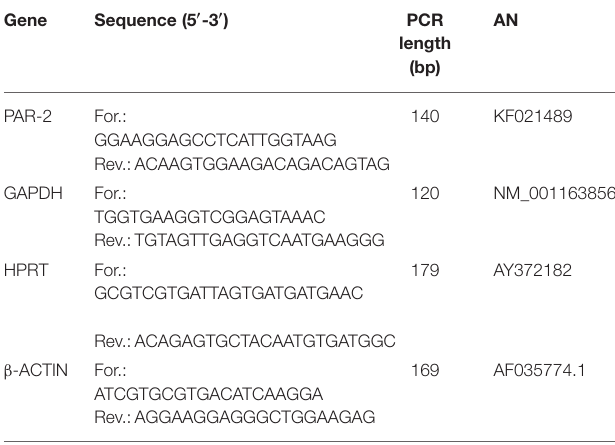
TABLE 1 | Forward and reverse primer sequences, polymerase chain reaction (PCR) product lengths and accession numbers (AN) in the NCBI (National Center of Biotechnology Information)